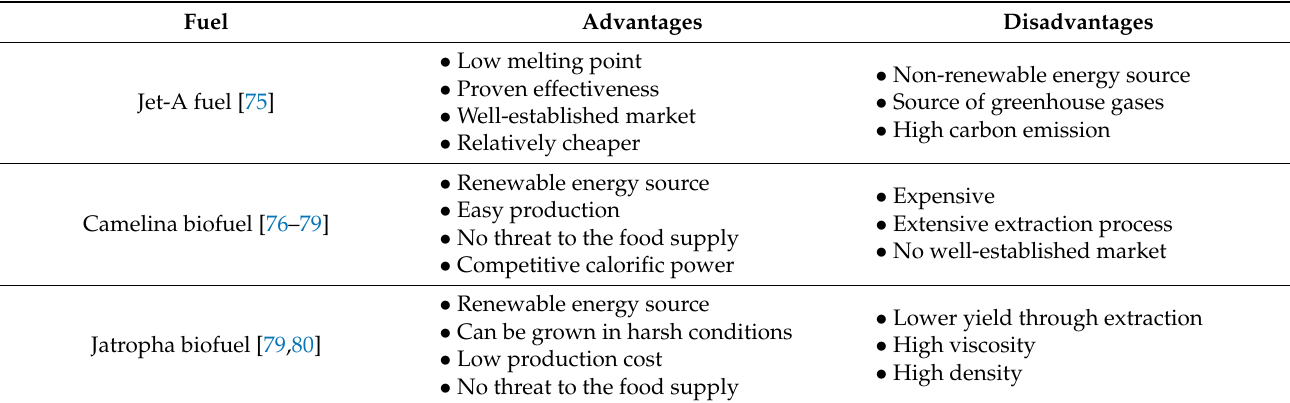
Table 8. Biofuel comparison—the best available options which can be achieved in the UAE. Fuel